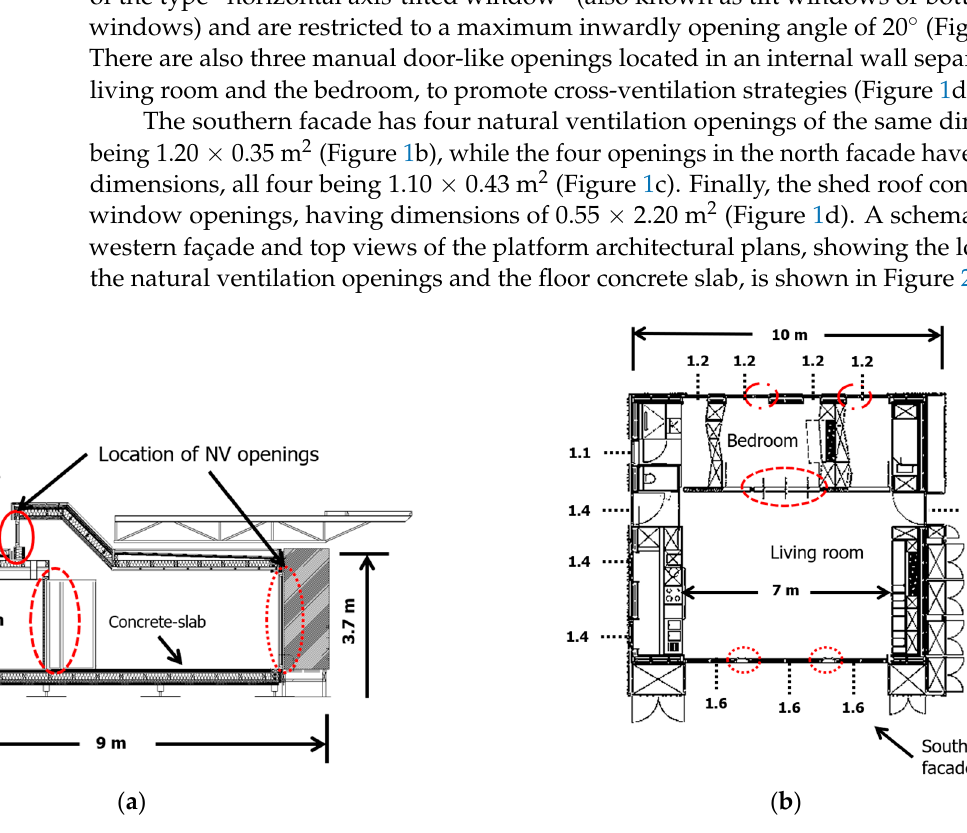
Figure 1. Architectural features: ( a ) floor concrete slab, ( b ) programmable solar shades and natural ventilation openings (inside red squares) on the south glazed façade, ( c ) the north facade, ( d ) and the shed roof.